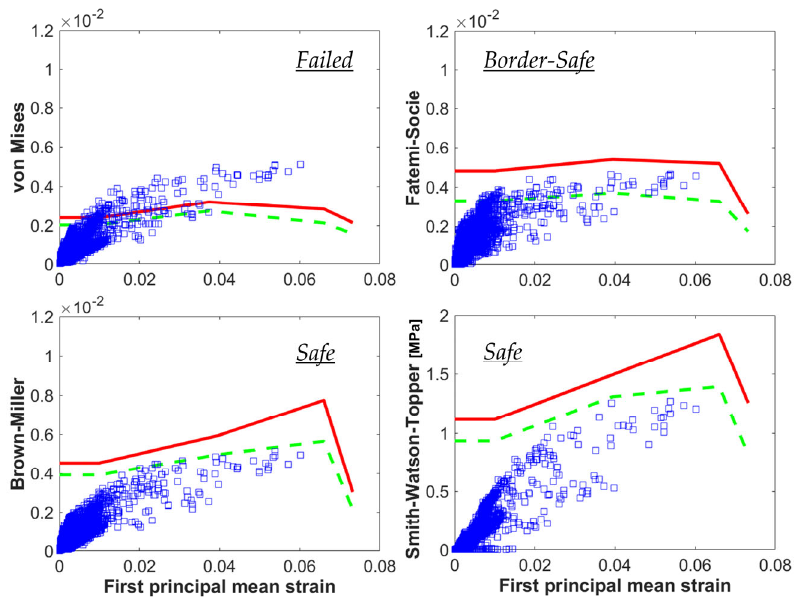
Figure 7. Results of a coupled in vitro and in silico study on the fatigue behavior of peripheral stents, adapted with permission from [14] (Elsevier, 2023); considering the same experimental outcome (safe), the use of different fatigue criteria for calculating the parameters for each element of the numerical model (blue boxes) led to different predictions (i.e., different distances from the material limit curves, in green and red), proving a better accuracy of the critical plane-based approaches compared to the von Mises.